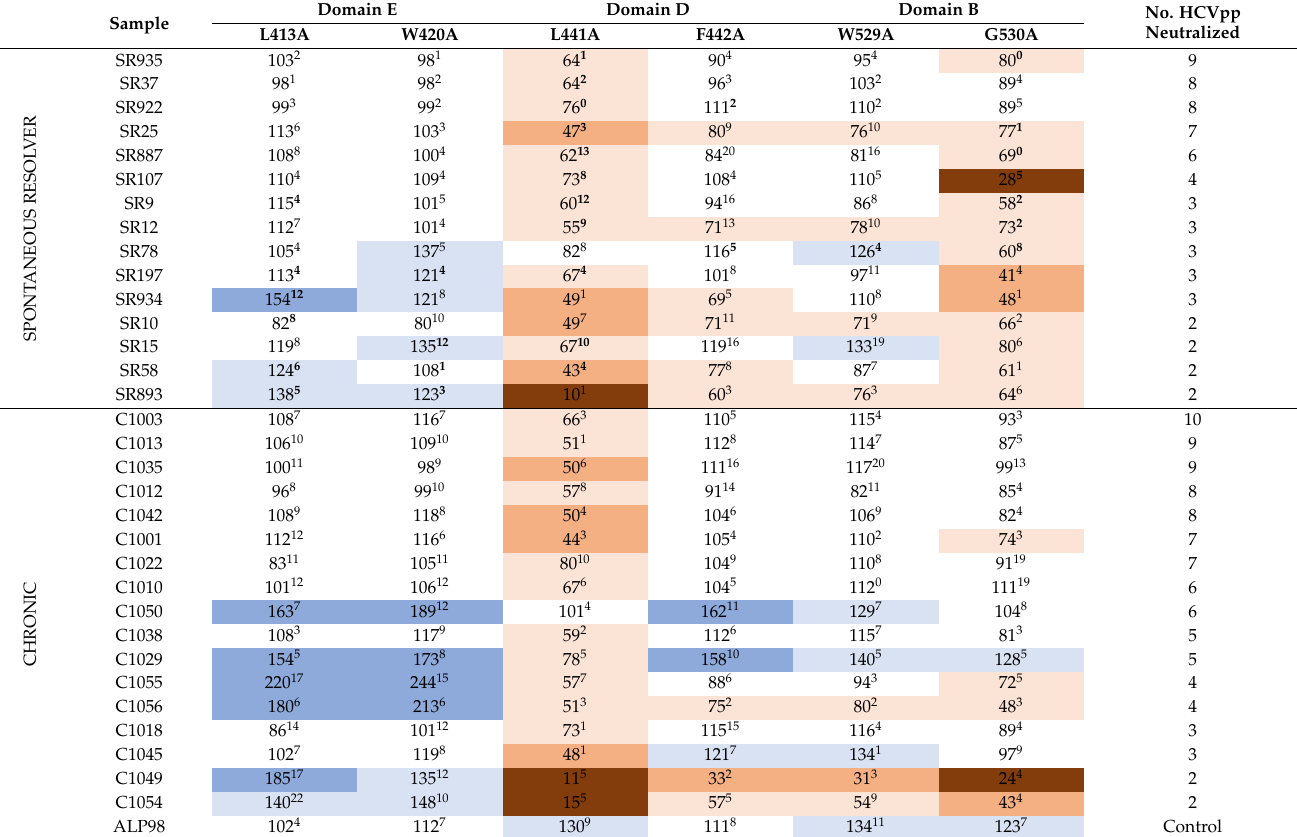
Table 4. E1E2 mutagenesis binding